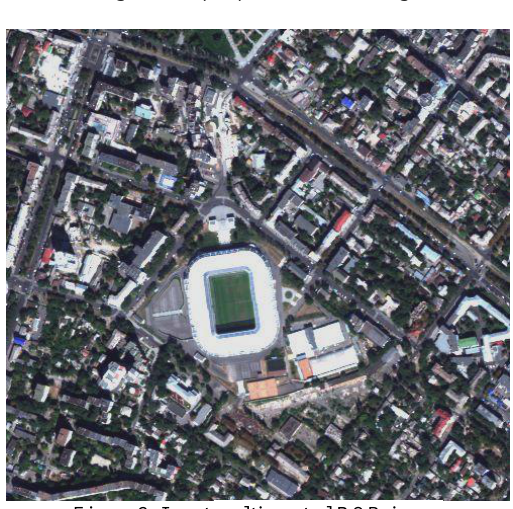
Figure 2. Input multispectral RGB